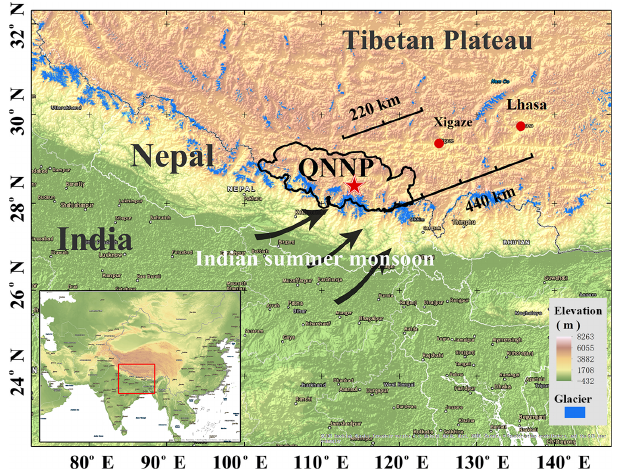
Figure 1. Location of Qomolangma National Nature Preserve (QNNP). The red star shows the location of the monitoring station in QNNP. The red dots show the locations of the two largest cities in Tibet (Lhasa and Xigaze), with the scale bars giving their distances from the